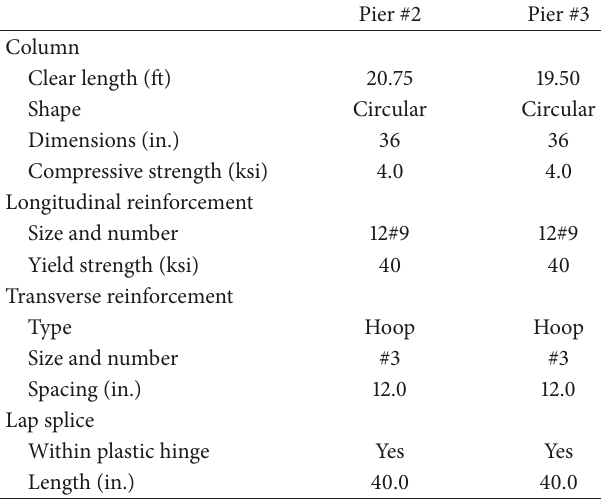
Table 3: Bridge #2-E columns’ geometric properties and reinforce- ment